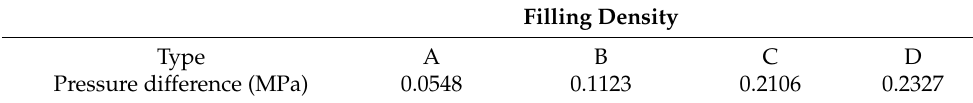
Figure 10. Schematic diagram of through flow resistance measurement test block diagram. Measure the inlet and outlet pressure differences of four isothermal containers A–D ten times and obtain the average value. The test results are shown in Table 3. It can be observed that the greater the filling density of copper wire, the greater the through flow resistance. Table 3. Through flow resistance of isothermal capacitor under different filling densities.